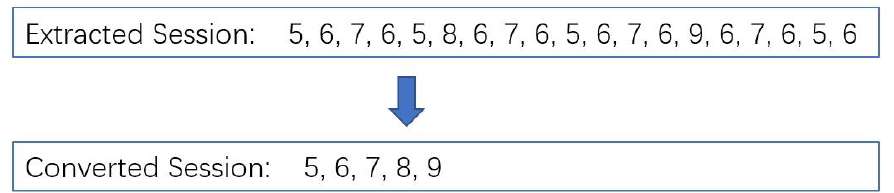
Figure 4. The extracted session and the converted session. The numbers denote the intrusion actions.